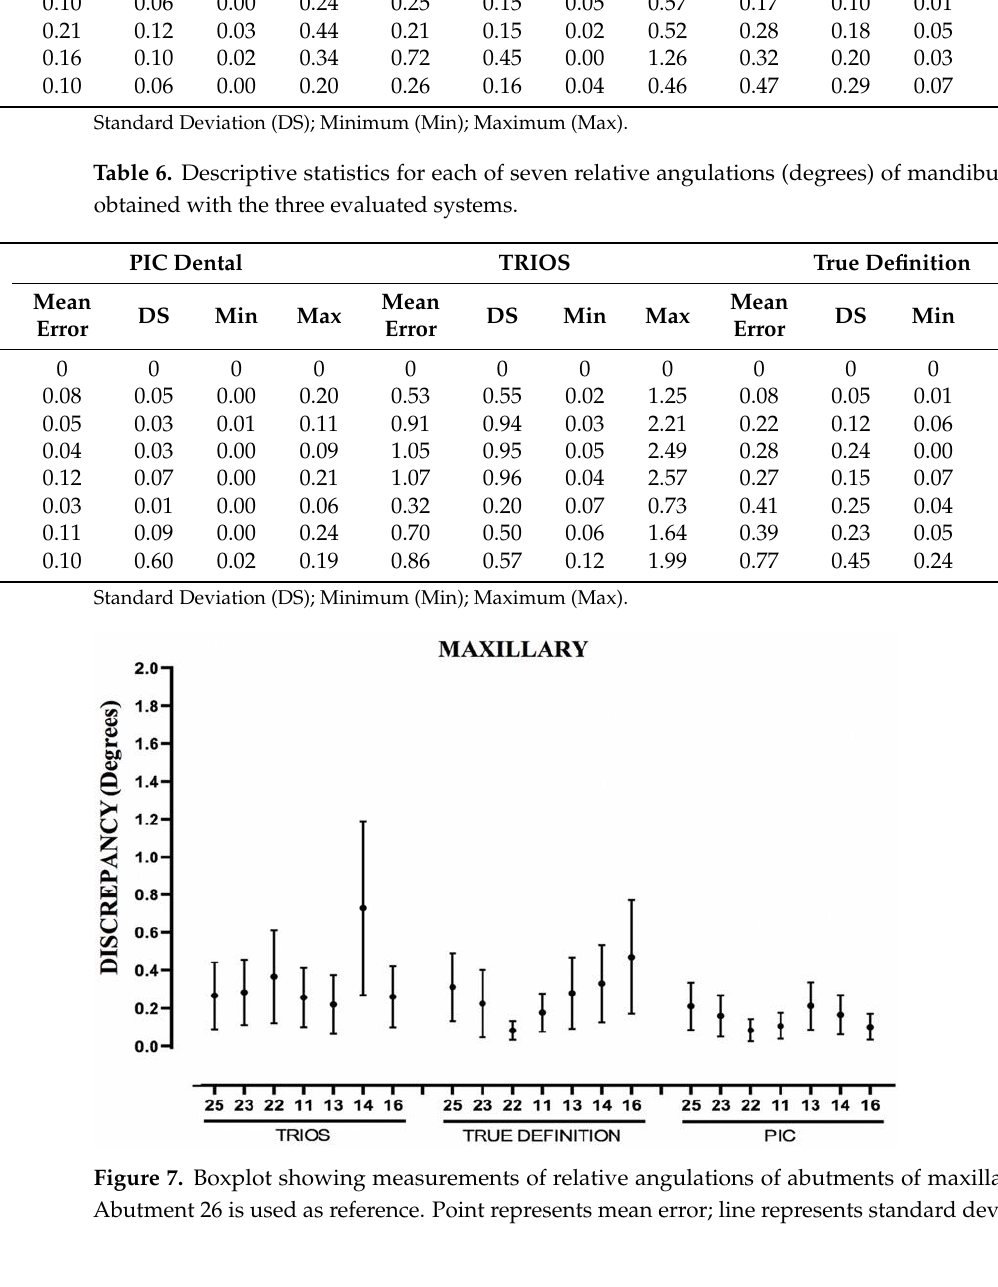
Figure 8. Boxplot showing measurements of relative angulations of abutments of mandibular arch. Abutment 46 is used as reference. Point represents mean error; line represents standard deviation. The greatest difference between measurements for an abutment in the maxillary arch (Table 5) was 0.44 degrees for PIC, 1.01 degrees for TD, and 1.26 degrees for T; in the man- dibular arch (Table 6), it was 0.24 degrees for PIC, 1.61 degrees for TD, and 2.57 degrees for T. Table 5. Descriptive statistics for each of seven relative angulations (degrees) of maxillary arch ob- tained with the three evaluated systems. ANGULATION DEVIATIONS